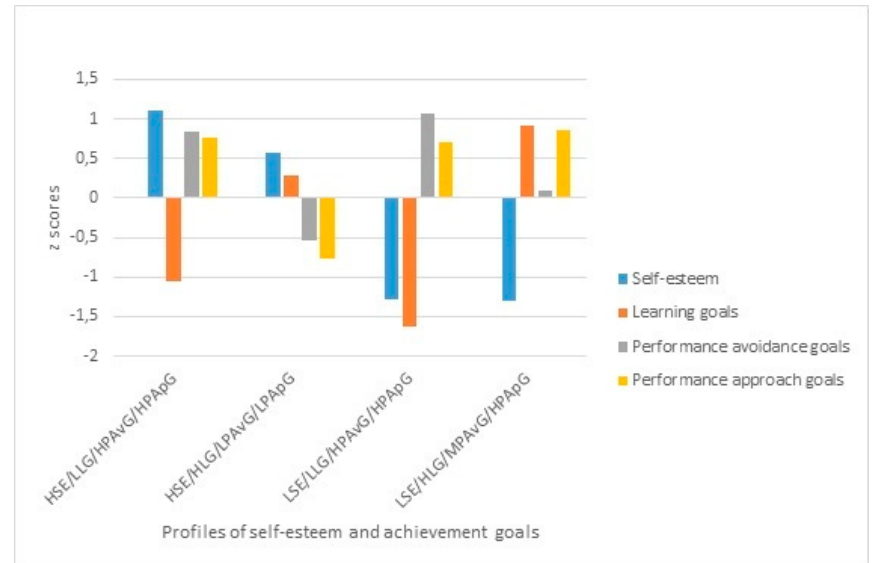
Figure 2. Graphical representation of profiles of self-esteem and achievement goals. Note. HSE / LLG / HPAvG / HPApG: Profile of high self-esteem, low learning goals, high performance avoidance goals, and high performance approach goals; HSE / HLG / LPAvG / LPApG: Profile of high self-esteem, high learning goals, low performance avoidance goals, and low performance approach goals; LSE / LLG / HPAvG / HPApG: Profile of low self-esteem, low learning goals, high performance avoidance goals, and high performance approach goals; LSE / HLG / MPAvG / HPApG: Profile of low self-esteem, high learning goals, medium performance avoidance goals, and high performance approach goals.